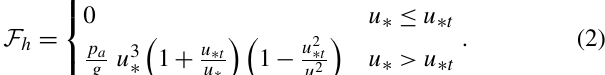
Table 1. Dust aerosol size distribution in LOTOS-EUROS. Bins dust_ff dust_f dust_ccc dust_cc dust_c Diameter 0.01–1 1–2.5 7–10 range